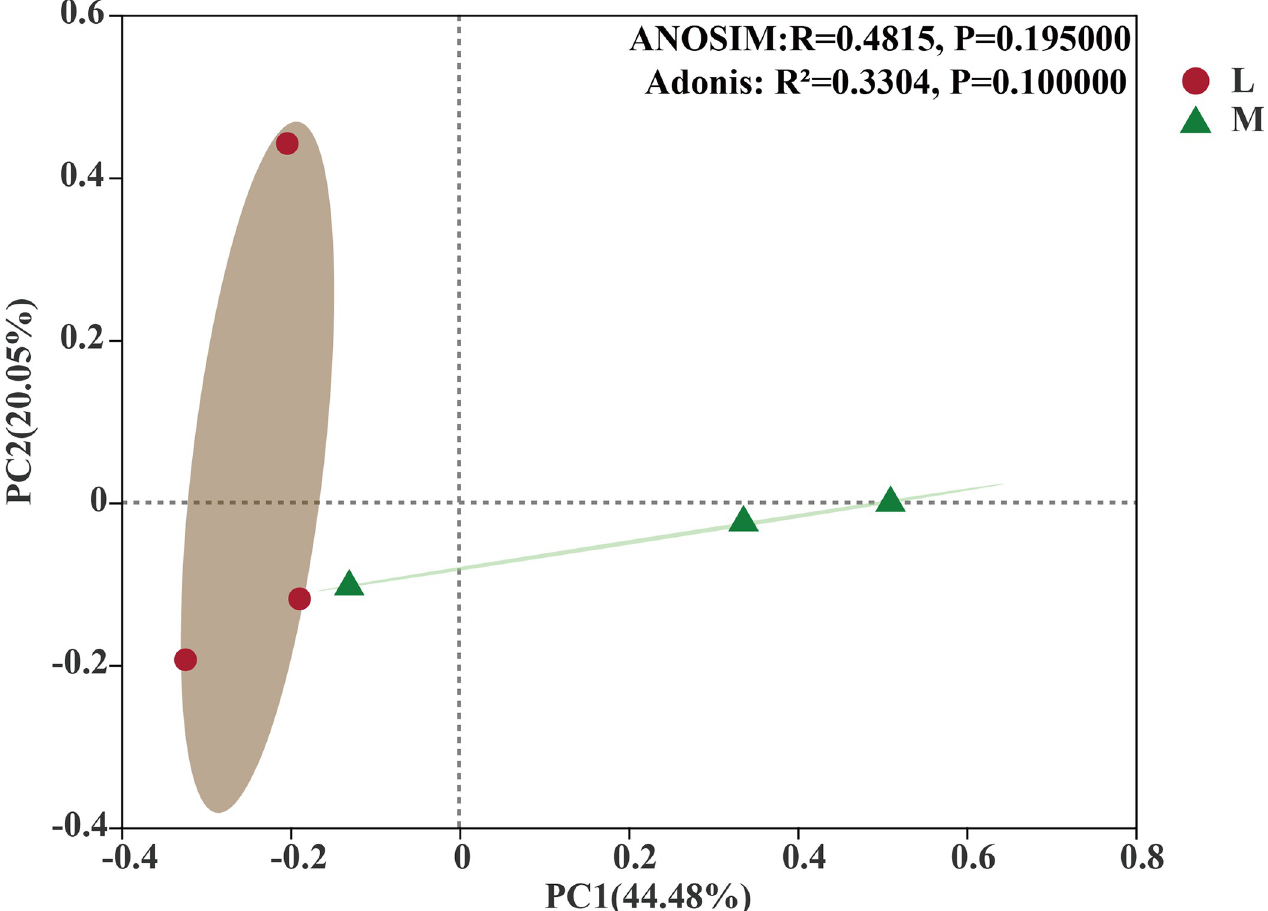
Fig 12. Principal coordinate analysis (PCoA) of fungal communities between moss- (M) and non-moss growth(L) areas in litchi orchard based on Bray– Curtis distances.